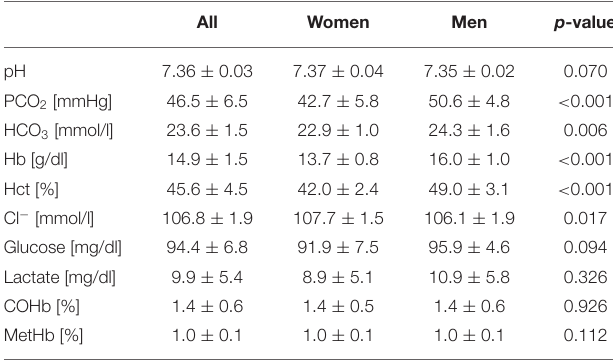
TABLE 1 | Results of blood gas analysis for women and men as mean ± standard deviation (Student’s t -test).